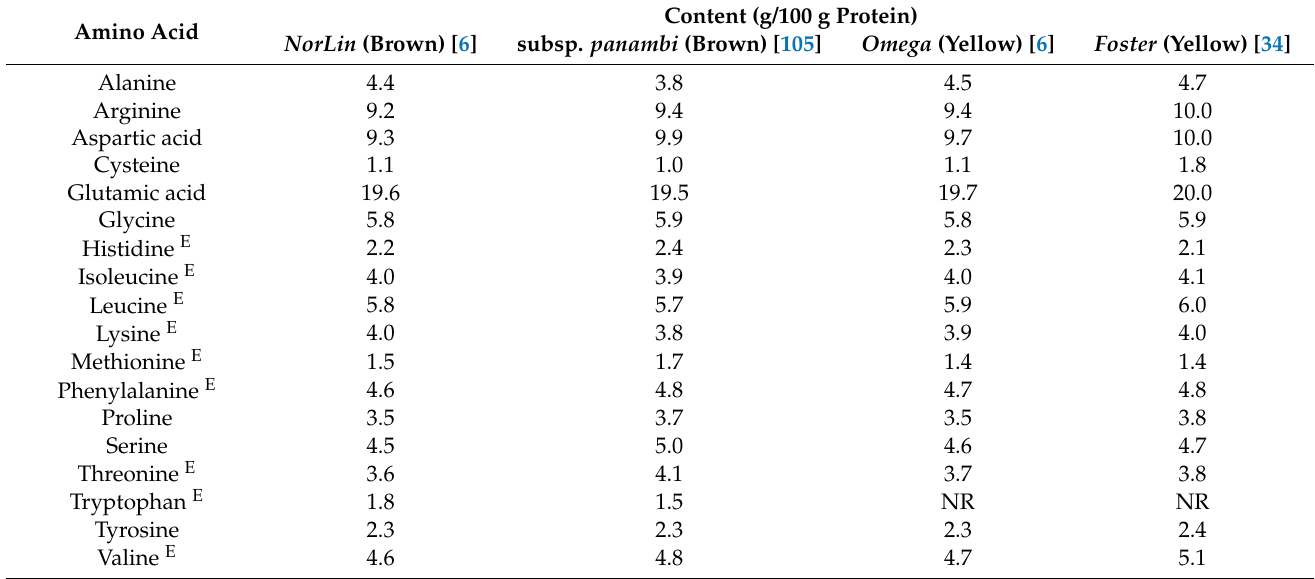
Table 4. Amino acid composition of flaxseed from three cultivars and one